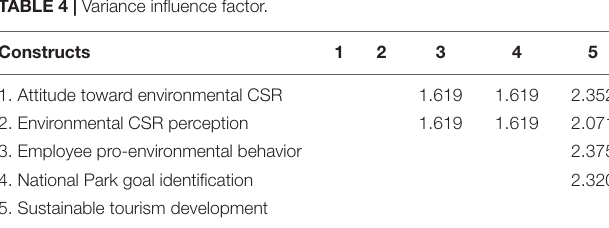
TABLE 4 | Variance influence